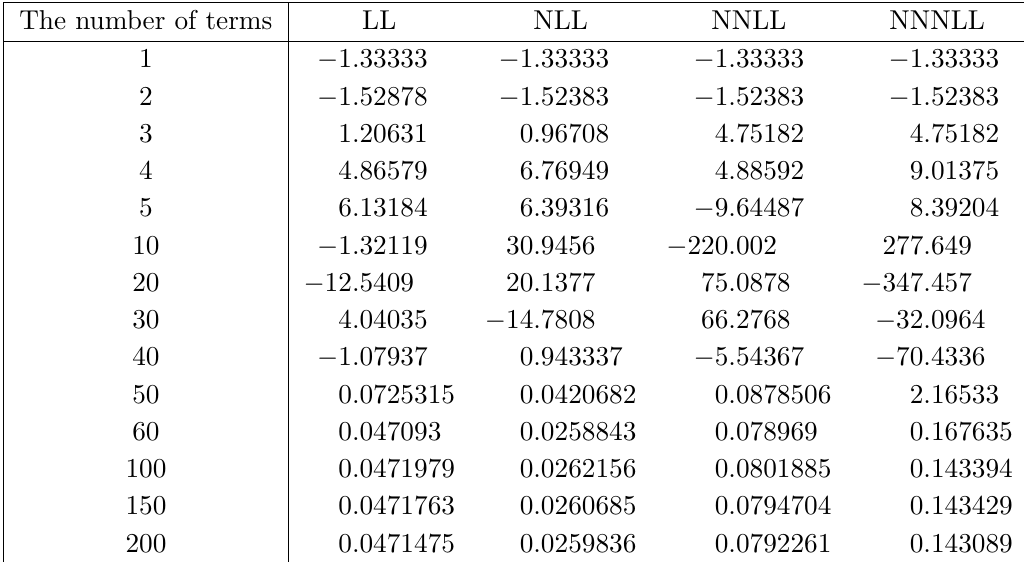
Table 3 . Estimates of the normalization constant N perturbative series of the RG-improved